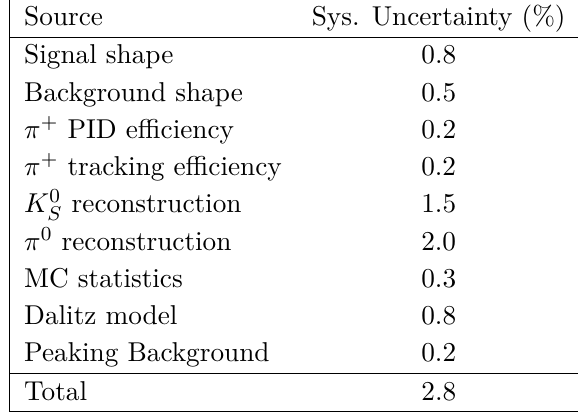
Table 8 . Systematic uncertainties in the BF